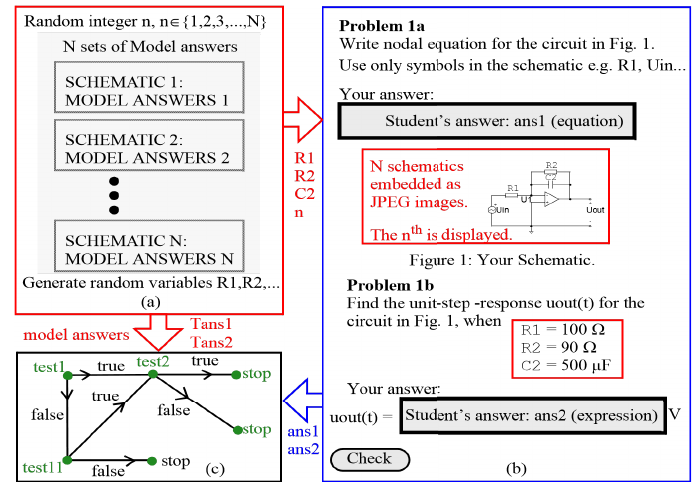
Fig. 1. A STACK quiz: a) Question Variables, b) Question Text and c) Response Tree (the acyclic directed